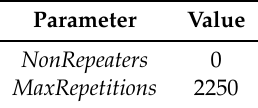
Table 7. GetBulkRequest